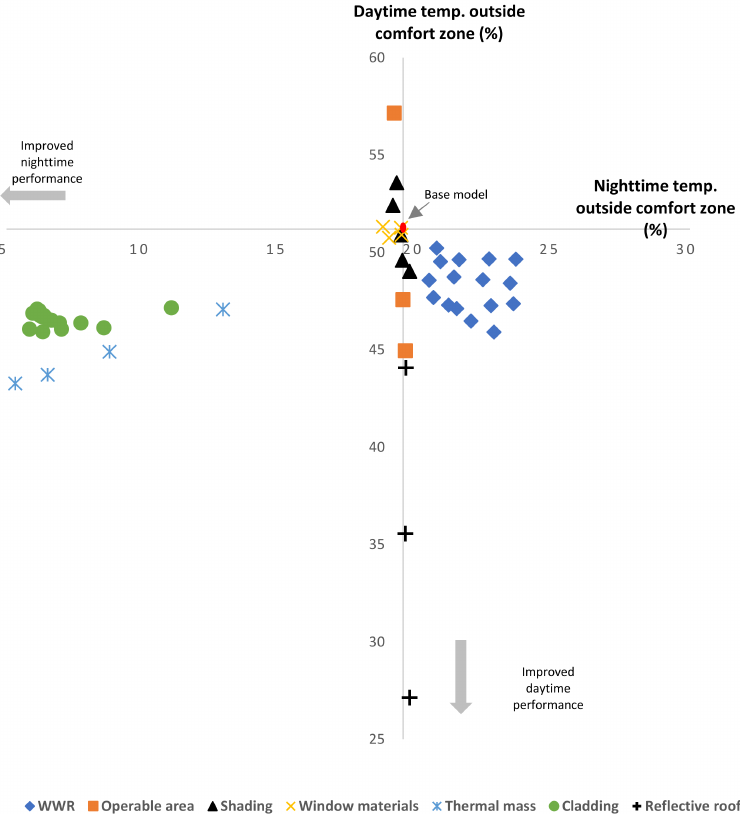
Figure 6. Effect of each parameter on the percentage of operative temperatures outside the adaptive comfort zone during daytime and nighttime hours. Table 4. Effects of wall cladding on thermal performance of the base